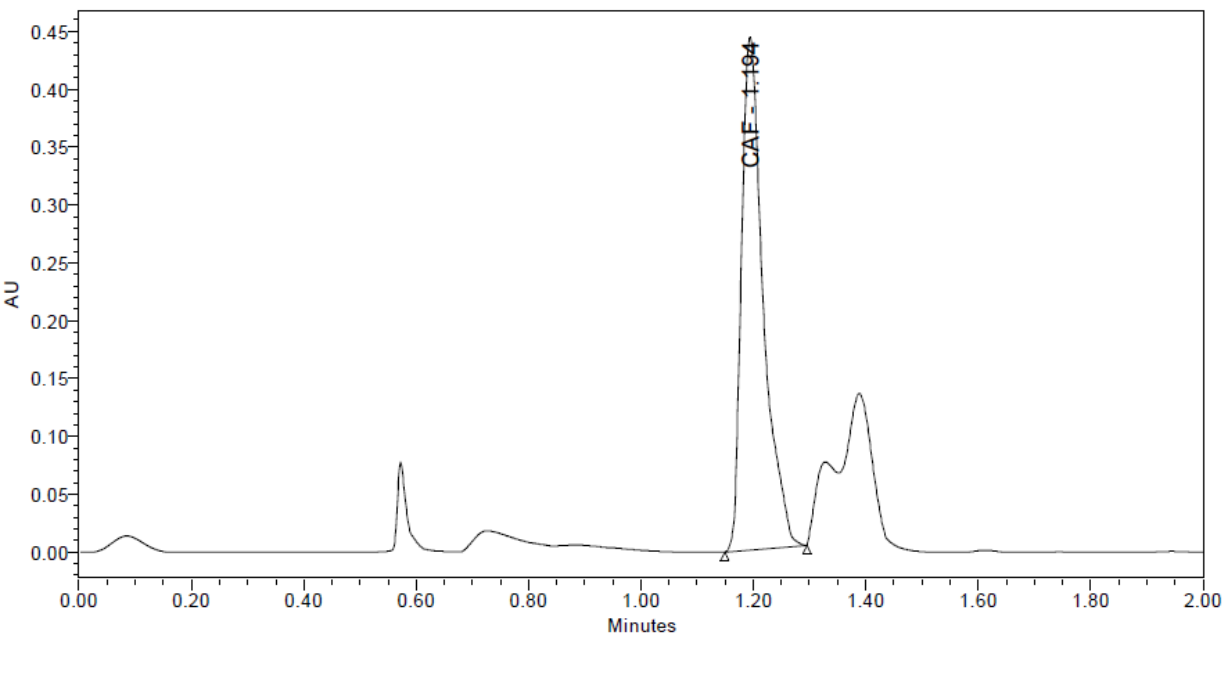
Figure 8. Chromatogram of PCM and CAF after forced degradation by 2 M HCl.